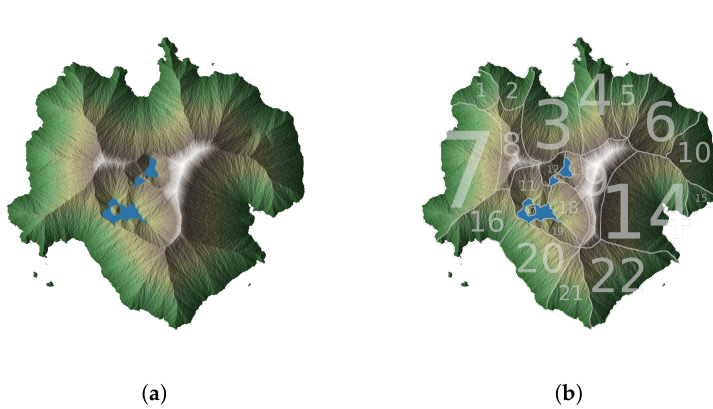
Figure 7. ( a ) Fictional island. ( b ) Sectors considered for a wind-driven fire type.